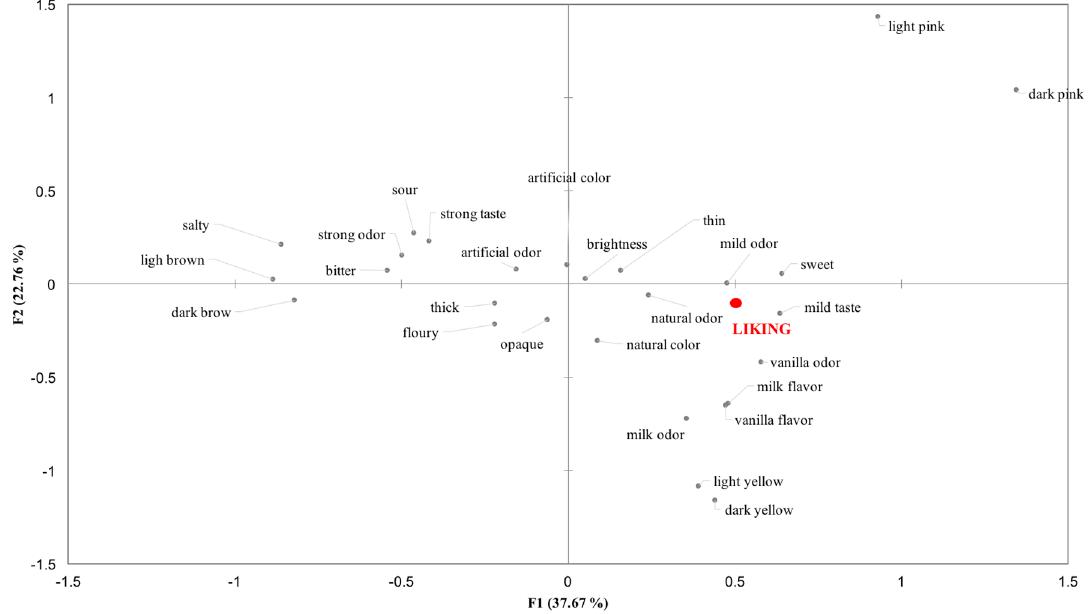
Figure 6. Attributes plot obtained from CATA total frequency counts and liking. Underline terms described samples that obtained higher liking scores while terms in italic describe mainly the disliked samples.